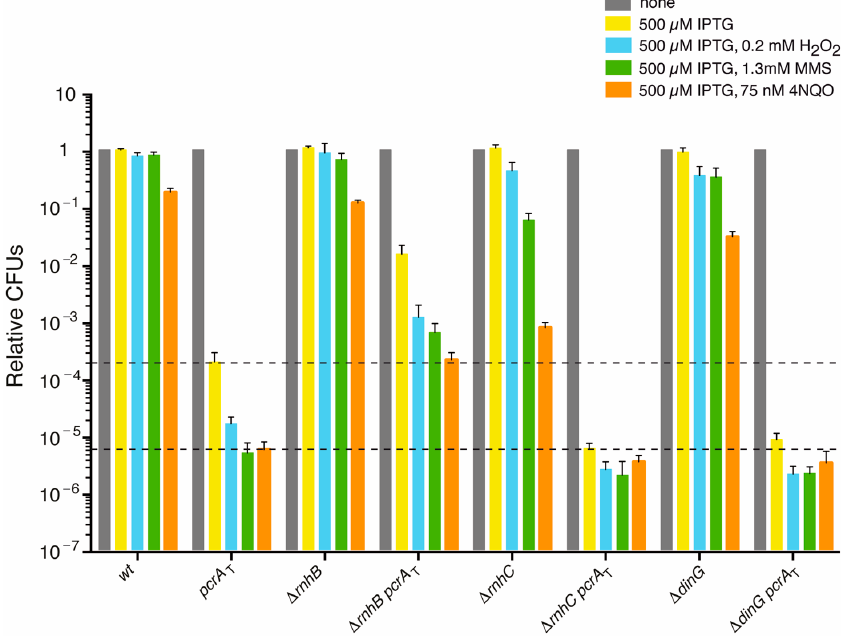
Figure 1. PcrA lethality is partially suppressed by rnhB inactivation, but not by rnhC or dinG inactivation. Log phase cultures of wt , single ( pcrA T , ∆ rnhB , ∆ rnhC or ∆ dinG ) and double mutant ( pcrA T ∆ rnhB , pcrA T ∆ rnhC or pcrA T ∆ dinG ) strains were diluted, plated on LB agar and incubated overnight at 37 ◦ C (grey bars). Lethality assays showing cell viability upon PcrA depletion in the pcrA T , ∆ rnhB pcrA T , ∆ rnhC pcrA T , or ∆ dinG pcrA T strain containing 500 µ M IPTG (yellow bars). Log phase cultures of the indicated strains were diluted and plated on LB agar containing IPTG (500 μ M, yellow bars) and H 2 O 2 (0.2 mM, blue bars), MMS (1.3 mM, green bars) or 4NQO (75 nM, orange bars). Experiments were performed at least four times. The dotted lines mark the upper and lower limit of the cell viability rate upon PcrA depletion. Data are shown as the mean fractional survival ± SEM.